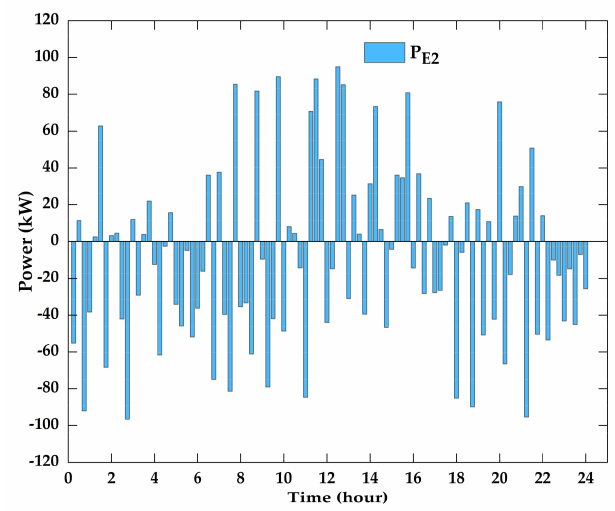
Figure 19. Exchange power of module B.